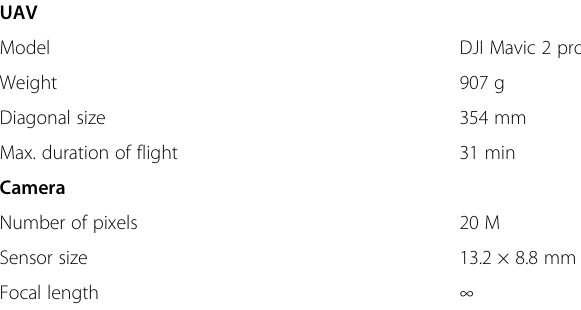
Table 1 Properties of the UAV and the installed camera